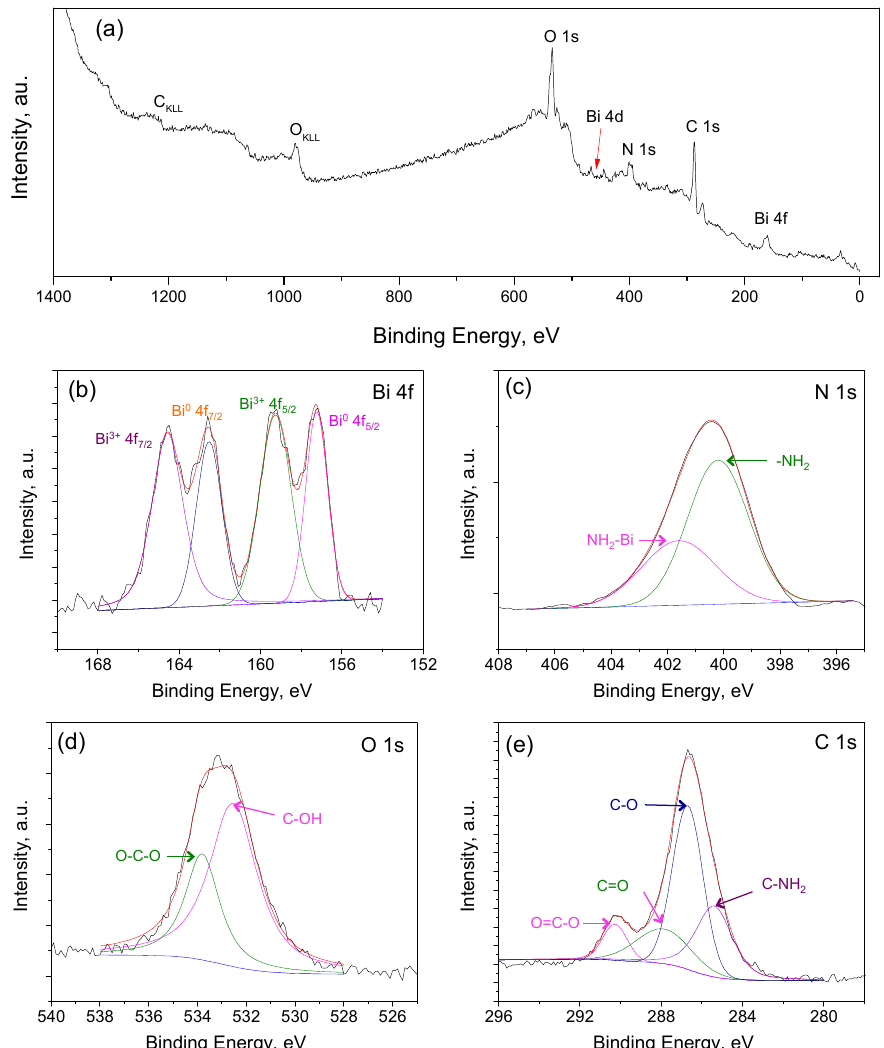
Figure 2. XPS analysis of a Bi-chitosan nanocomposite film. ( a ) Survey peak, ( b ) Bi 4f spectra, ( c ) N 1s spectra, ( d ) O 1s spectra, and ( e ) C 1s spectra.